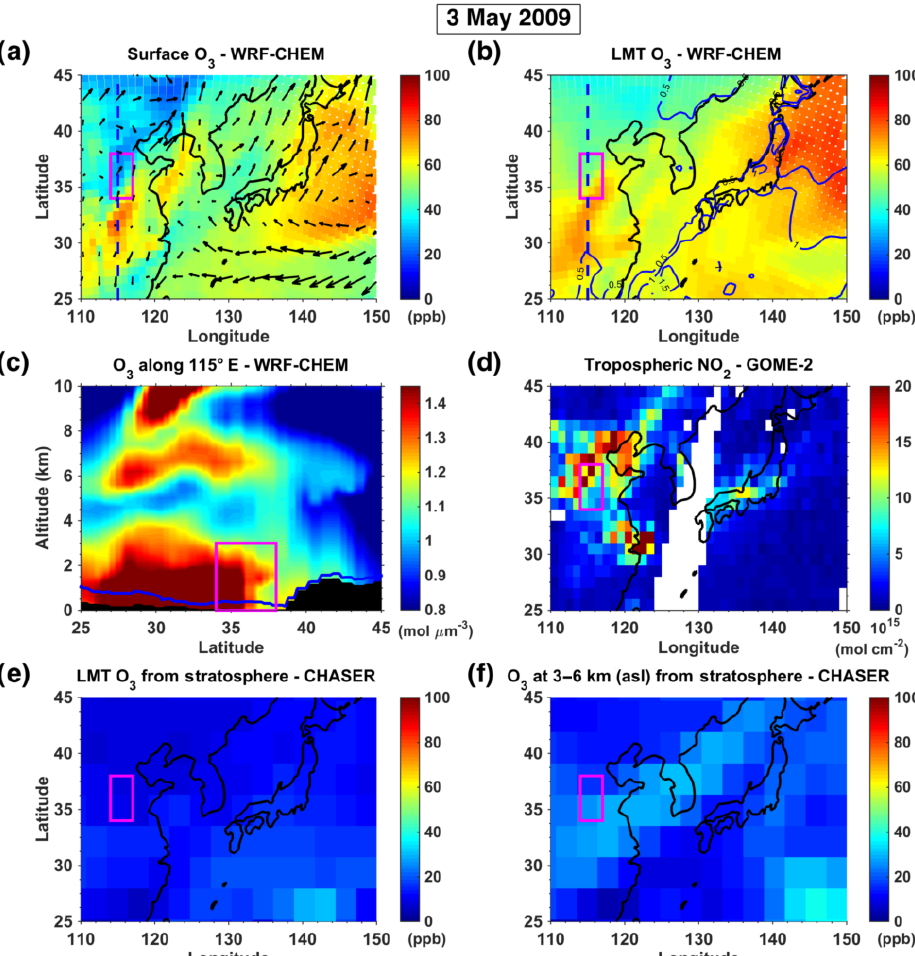
Figure 6. Ozone distribution over East Asia (a) at the surface and (b) in the LMT according to the WRF-Chem model on 3 May 2009 at 10:00JLT. Panels (a) and (b) also show surface winds (arrows) and mixing boundary layer height (blue contours) respectively. (c) Transect of vertical profiles of tropospheric ozone burden (in molµm − 3 of air) along the axis 115 ◦ E (indicated as a dashed blue line in panel a ) derived from WRF-Chem, with the mixing boundary layer height (blue) derived from ERA-I reanalysis and orography (black shading). (d) Tropospheric NO 2 distribution derived from GOME-2 measurements. Stratospheric ozone reaching (e) the LMT and (f) the atmospheric layer at 3–6km altitude, according to CHASER model simulations on 3 May 2009 at 10:00JLT. Magenta rectangles show the locations of the air masses tracked during the pollution event in early May